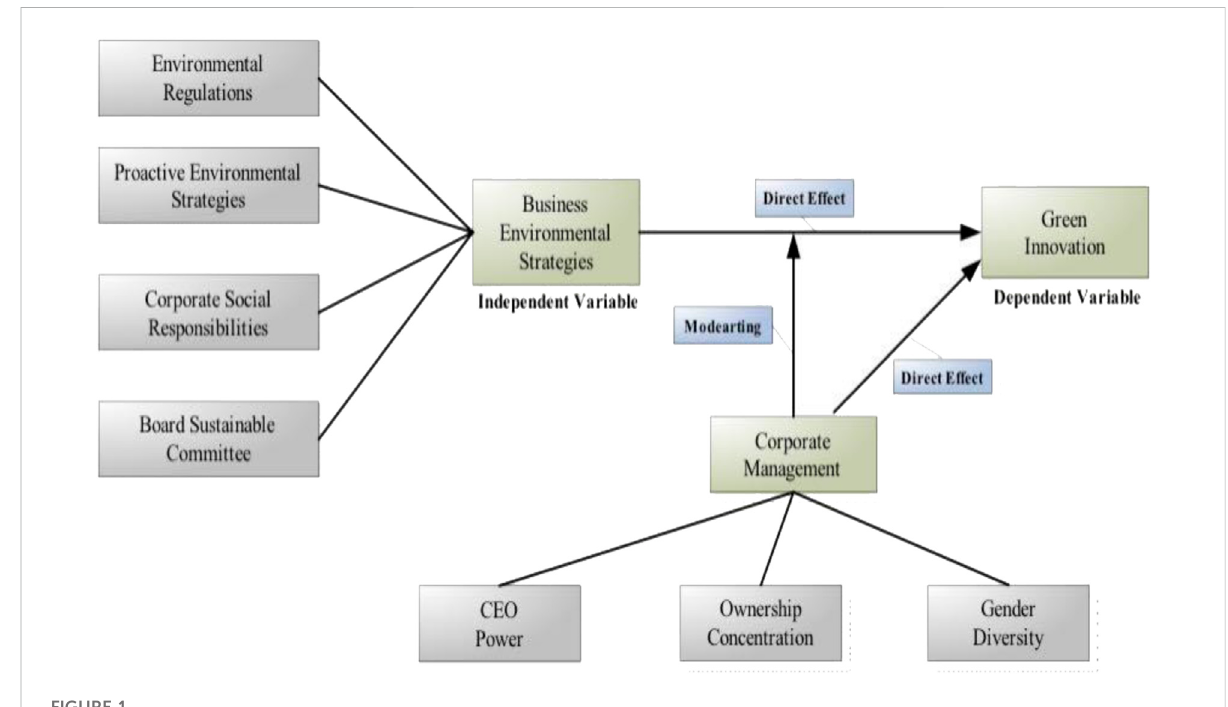
FIGURE 1 Context of